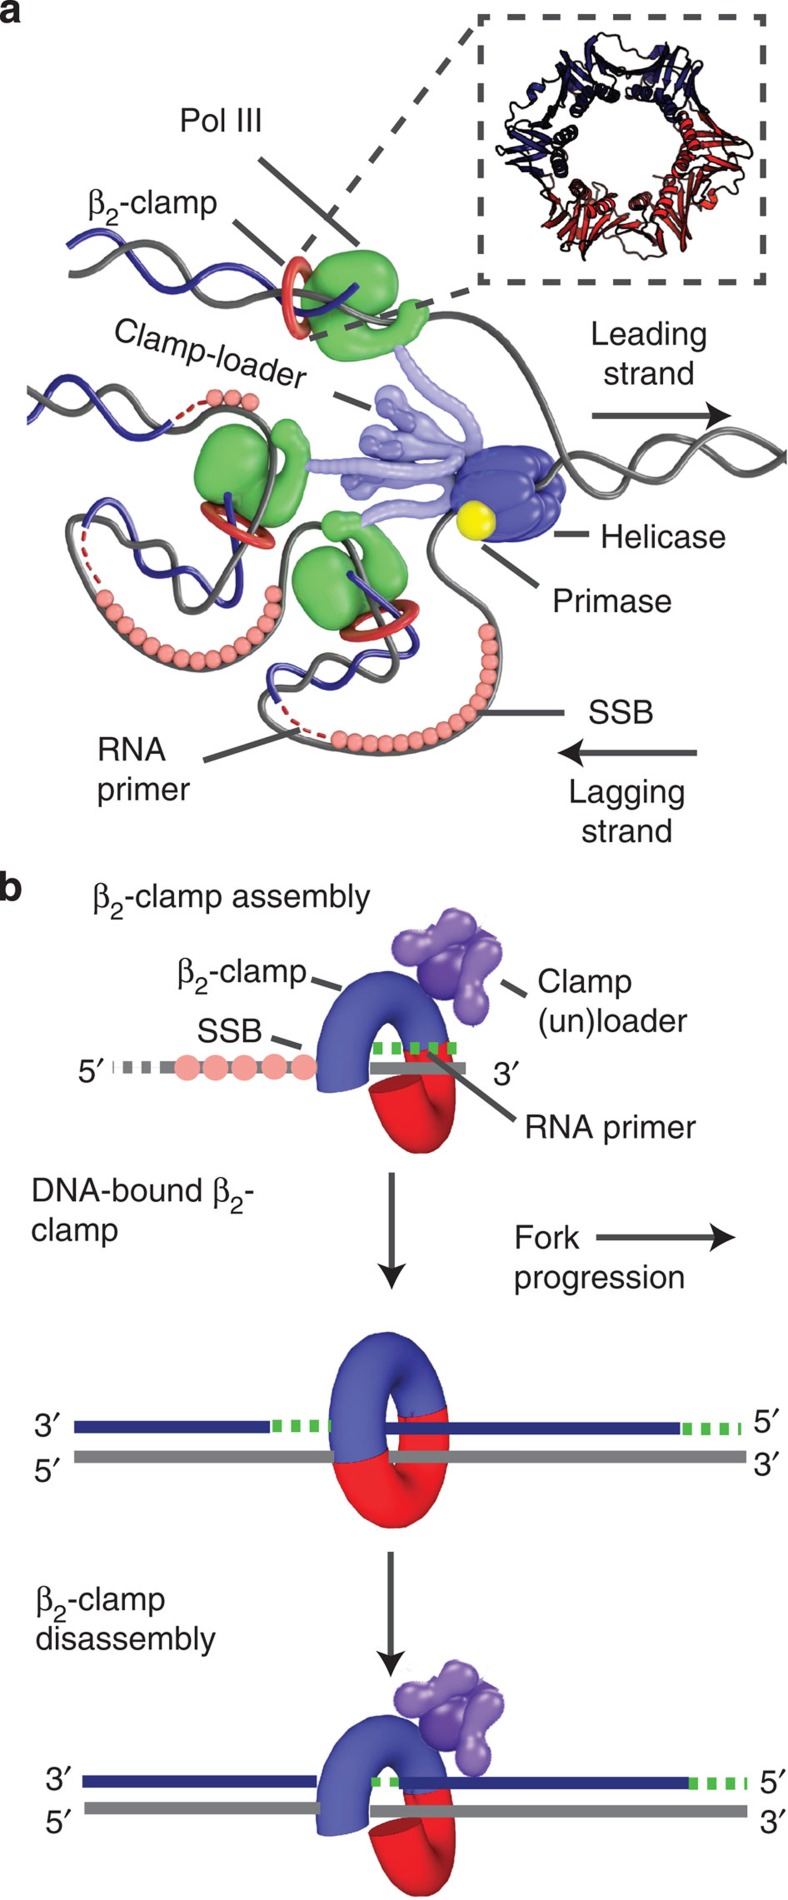
The E. coli replisome and β2-clamp assembly during replication.(a) The position of the β2-sliding clamp within the E. coli replisome complex. The helicase (DnaB) unwinds dsDNA ahead of the replicative polymerase (DNA Pol III), which subsequently duplicates the template strands. Different configurations of Pol IIII are potentially possible. Primase (DnaG) synthesizes short RNA primers on the lagging strand for Okazaki fragment initiation. Single-stranded binding proteins (SSB) remove the secondary structure of ssDNA and protect it from digestion. To ensure sufficient processivity during replication, Pol III is tethered to the DNA by the β2-sliding clamp. β2 is assembled onto primer-template junctions by the multi-protein ((τ/γ)3δδ′χ) clamp-loader complex. (Inset) A ribbon representation of the DNA-bound β2-sliding clamp (generated using the Protein Data Bank (PDB) file, 2POL16). The β2-sliding clamp is a homo-dimer that consists of six globular domains16. The monomers are arranged in a ring that encircles the DNA70 and can slide freely along it. Different proteins can bind to the two hydrophobic pockets of the β2-clamp via a conserved sequence motif10. (b) The life cycle of the β2-clamp during replication. (top) The β2-clamp is actively loaded by the clamp-loader, which opens the closed clamp and places it onto dsDNA before release22. (middle) The β2-clamp remains DNA-bound as long as an Okazaki fragment is being synthesized. (bottom) After the β2-clamp has reached the end of an Okazaki fragment, DNA Pol III is signalled to release52. The β2-clamp is believed to be disassembled by the clamp-loader.